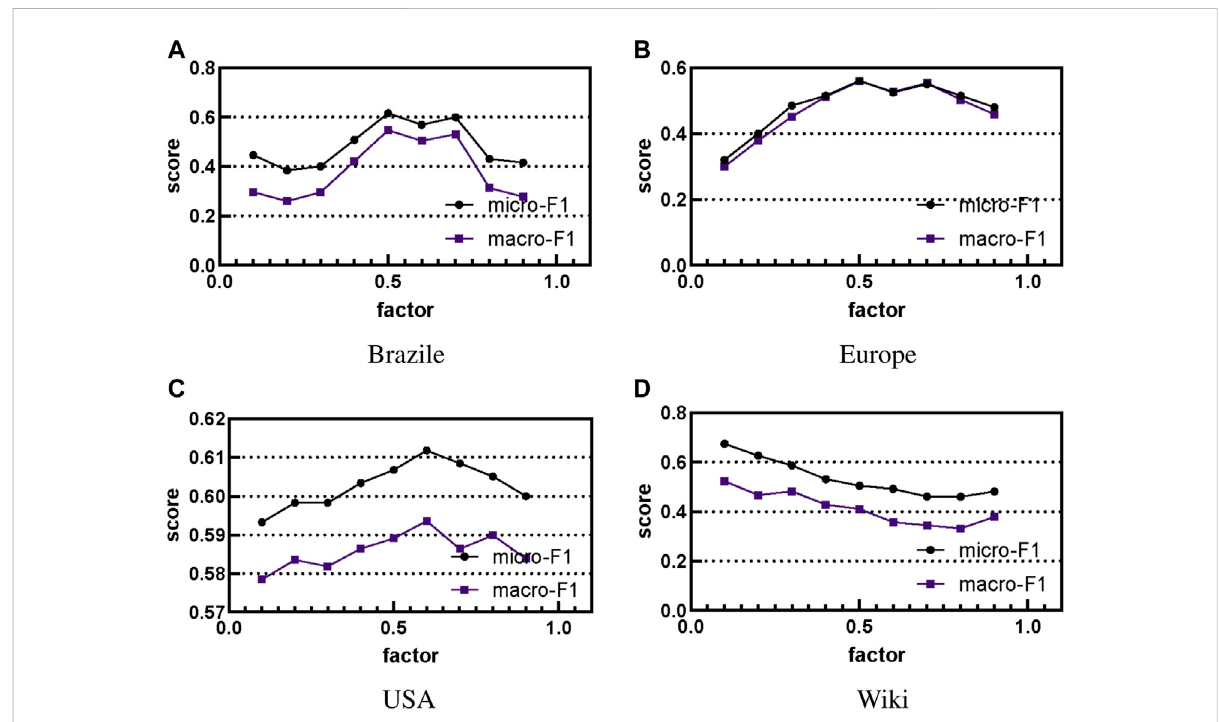
FIGURE 4 The results of the effect of attenuation factor on theperformance of thealgorithm. Weshow the scores of 4 algorithms under